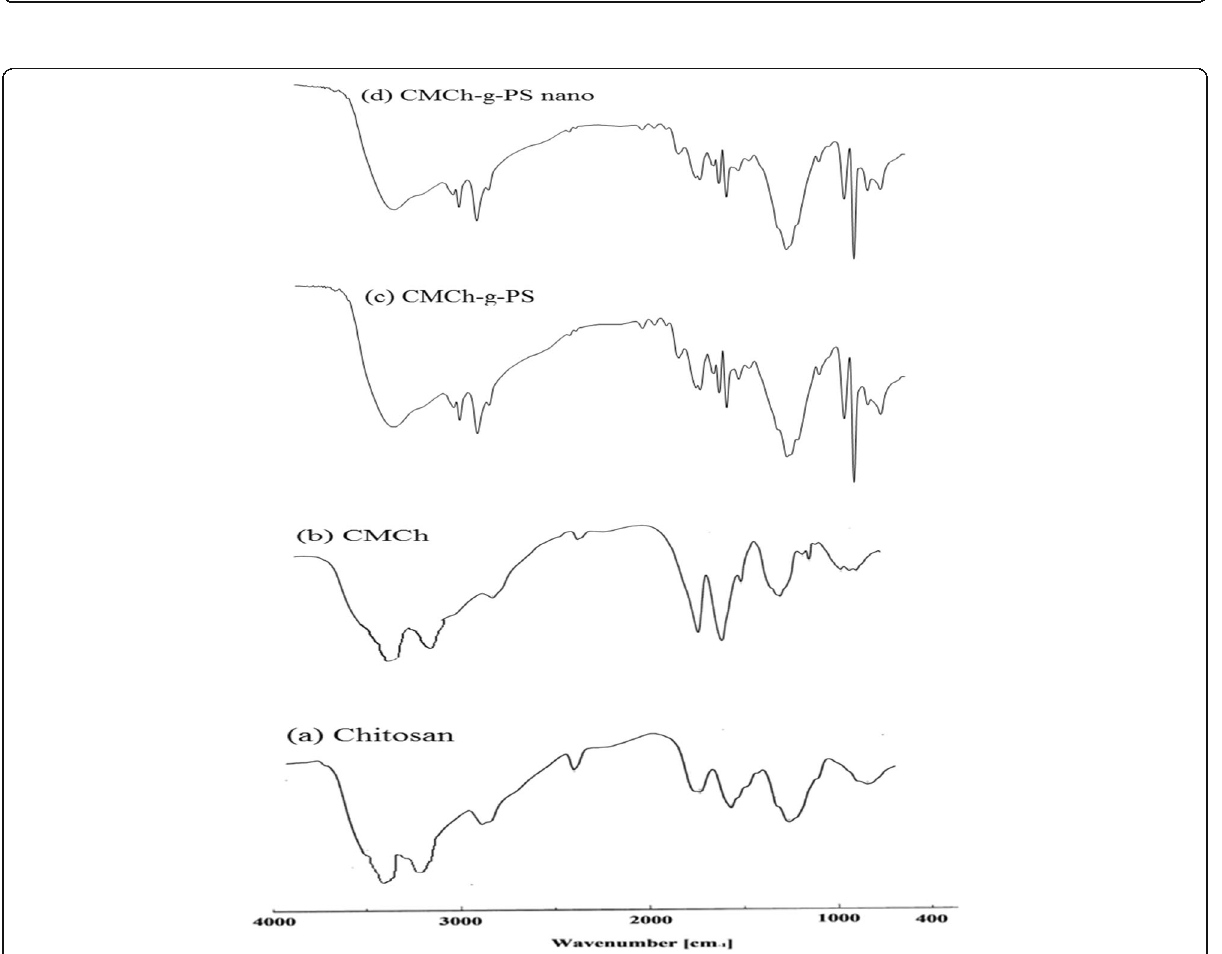
Fig. 4 Effect time on graft percentage (%G) and grafting efficiency (%GE) (Reaction conditions: 1 g CMCh, 3 M styrene, [APS]=0.6 g, temperature 60